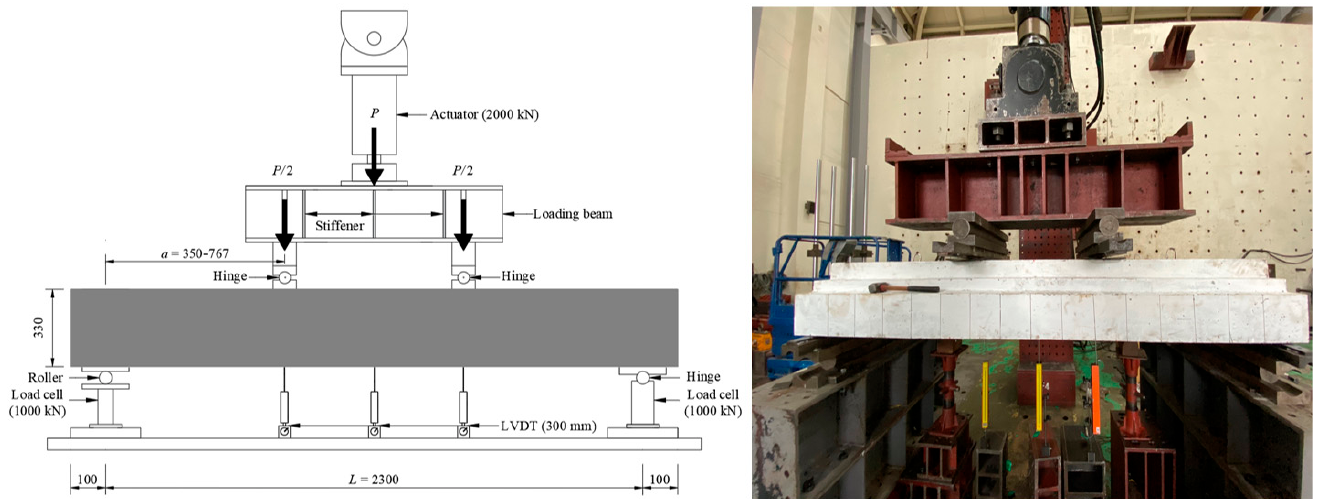
Figure 5. Test setup for the insulation panels (units: mm).